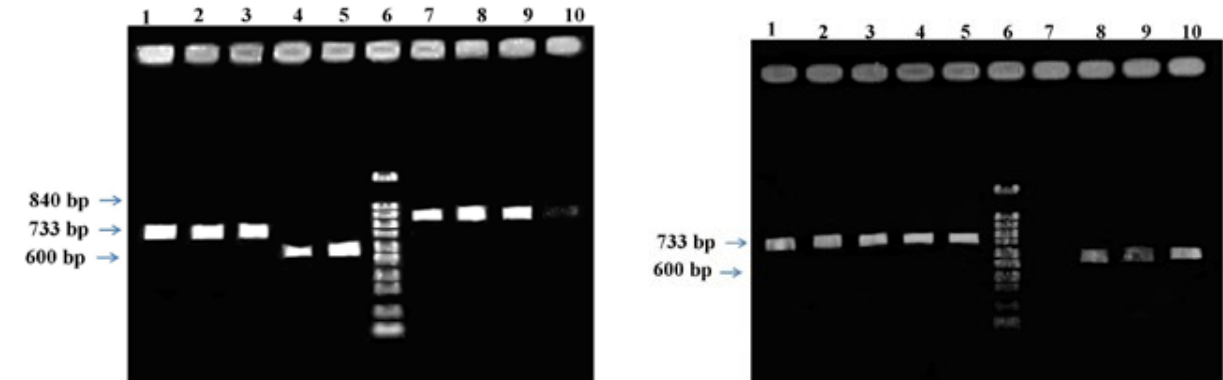
Figure 5. Gel electrophoresis pattern of PCR amplification products using Xylella fastidiosa specific primers. Left : PCR products from bacterial colonies isolated from almond samples amplified with primers RST31/RST33 (lanes 1, 2, 3), 272-1-int/272-2-int (lanes 4, 5), Dixon454fa/ Dixon1261rg (lanes 7, 8, 9); lane 10, PCR product from petioles of almond amplified with Dixon454fa/ Dixon1261rg primer pair; lane 6, 100 bp DNA ladder. Right : Lanes 1, 2, 3, 4 and 5, PCR products from bacterial colonies isolated from grapevine amplified with RST31/RST33 primer pair; lane 6, 100 bp ladder; lanes 7 and 8, PCR products from petioles of grapevine amplified with Dixon454fa/ Dixon1261rg (not amplification) and 272-1-int/272-2-int primer pairs, respectively; lanes 9 and 10, PCR products from bacterial colonies isolated from grape - vine amplified with primer pair